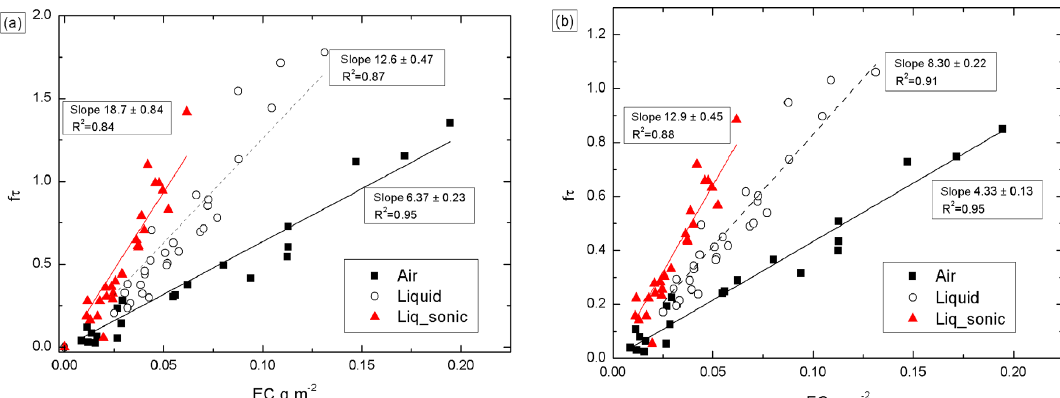
Figure 7. Linear regressions of transmittance-corrected optical depth f τ(λ = 530nm) vs. EC of the BC particles blown into the mixing chamber (Air), blown into water (Liquid), and blown into water and treated in the ultrasonic bath (Liq_sonic). The optical depths were corrected with the (a) f (Tr,V2010, ω o = 0 . 4) and (b) f (Tr, Q ,O2010). The regressions were calculated by forcing offset to 0.